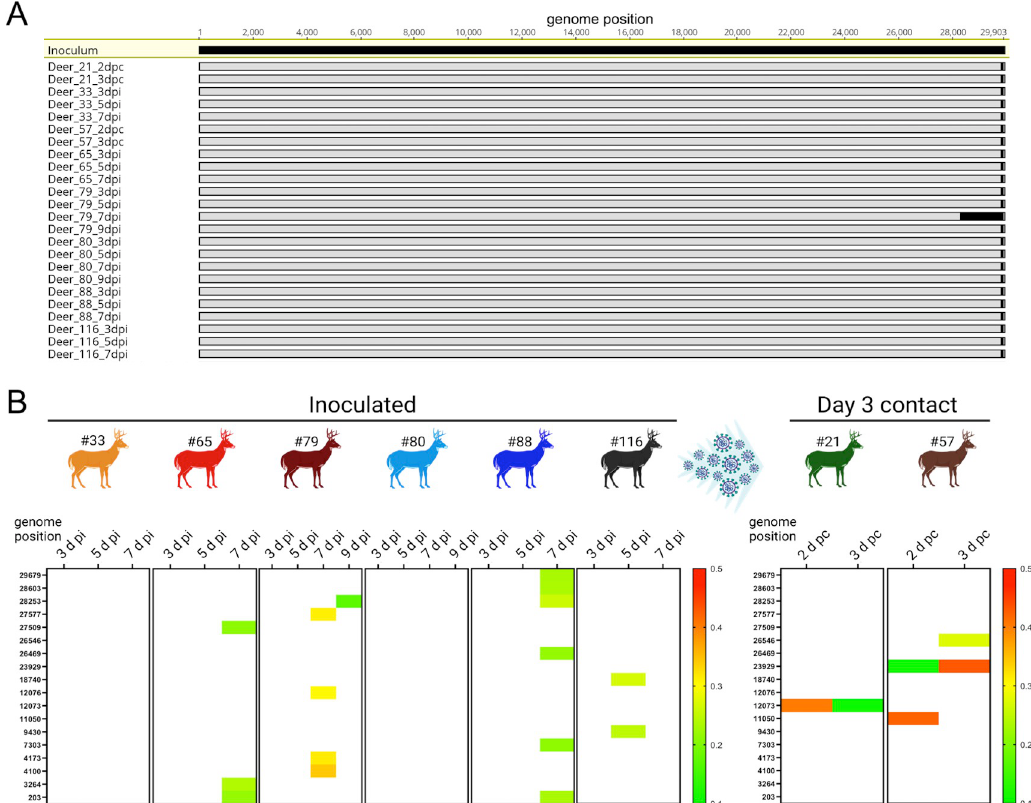
Fig 4. Low genetic diversity observed following SARS-CoV-2 replication and transmission in white-tailed deer. Genome sequences were obtained directly from nasal secretions from all the 6 inoculated fawns collected on days 3, 5, 7 and/or 9 post- inoculation (pi) and from oronasal secretions from the day 3 contact animals (n = 2) collected on days 2 and 3 post-contact (pc). A ) Whole genome sequence analyses of SARS-CoV-2 sequences recovered from all inoculated and contact fawns revealed no amino acid differences in the consensus SARS-CoV-2 genome in comparison to the genome sequence of the inoculum virus isolate NYI67-20. B ) Minor variant viral populations distributed throughout the virus genome from inoculated fawns on days 3, 5, 7 and/or 9 pi and from oronasal secretions from the day 3 contact animals (n = 2) collected on days 2 and 3 pc.